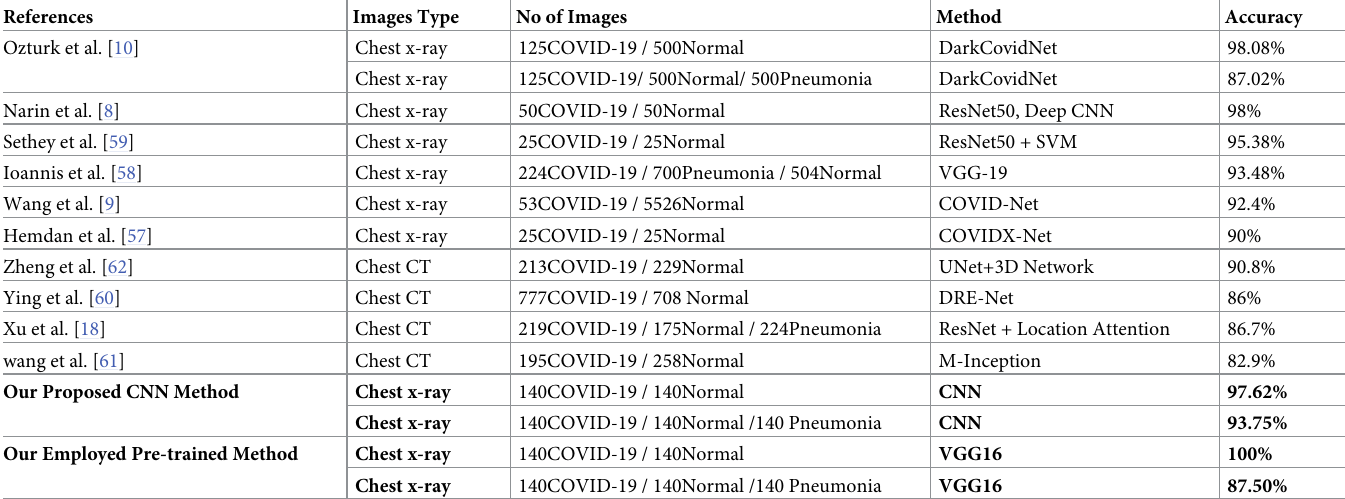
Table 10. Accuracy obtained by existing models and models used in the